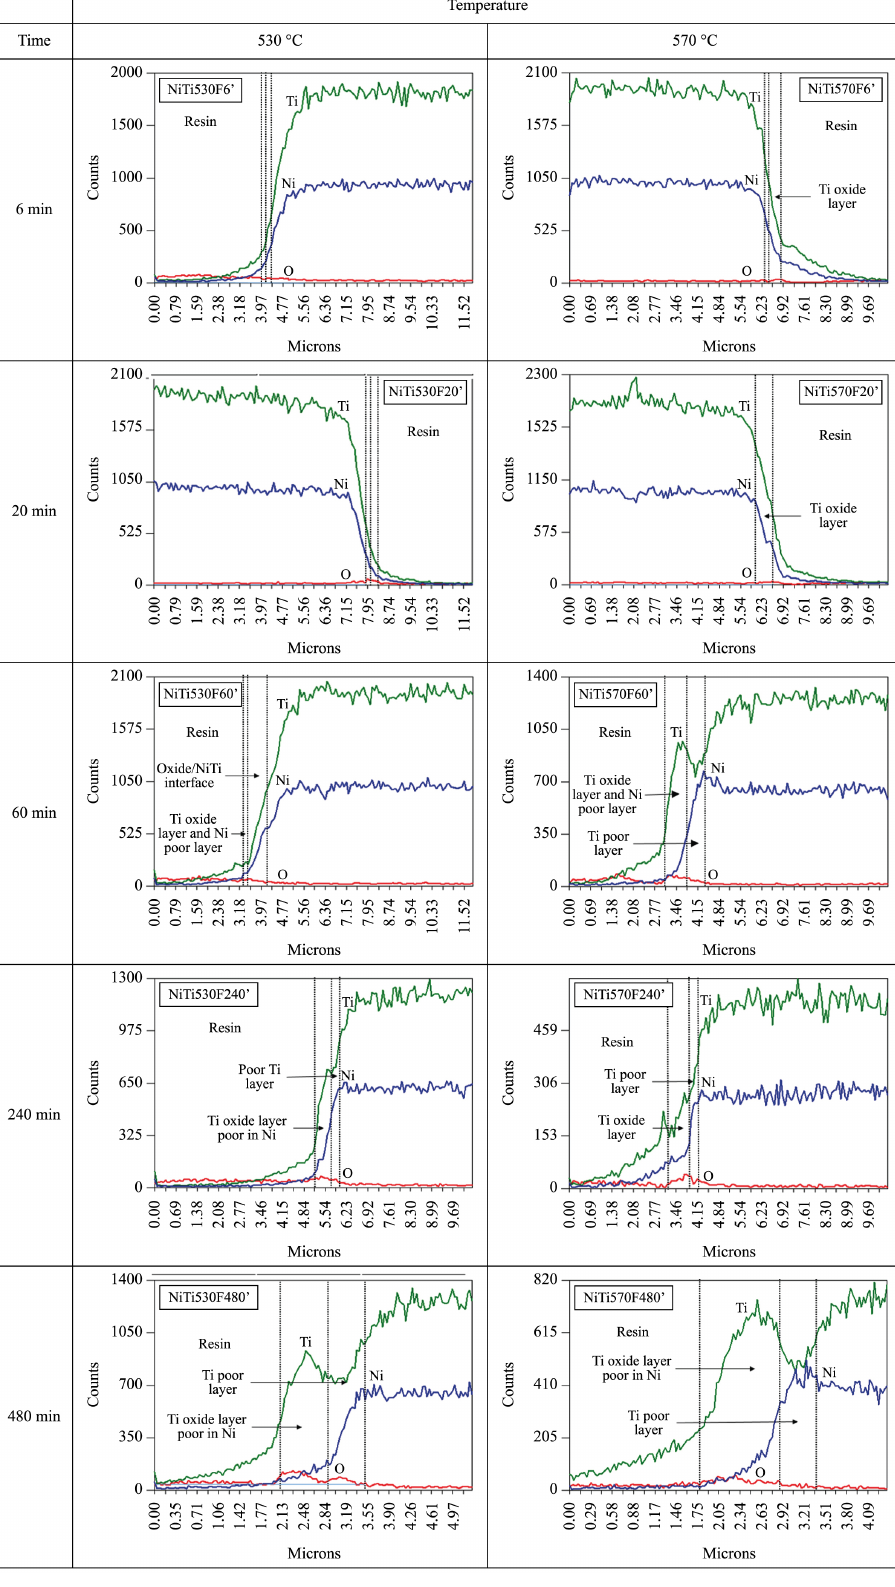
Figure 6. EDS samples exposed to different